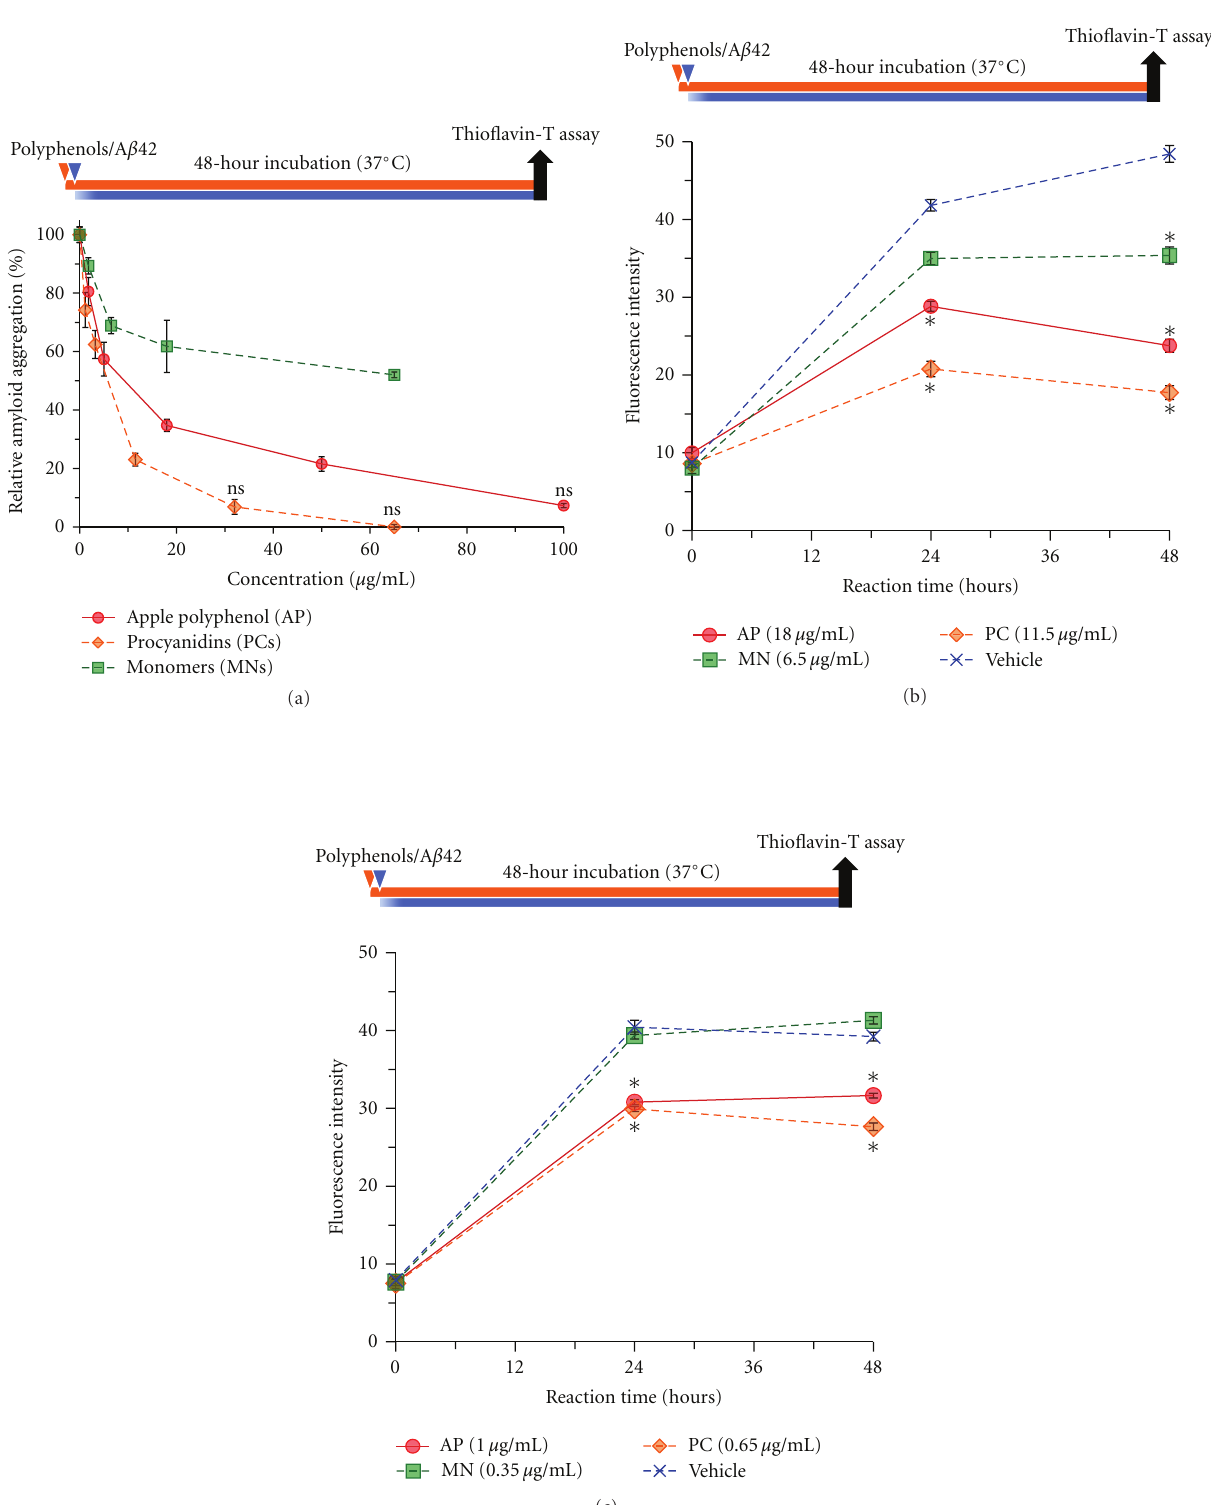
Figure 1: Procyanidins suppress A β aggregation in vitro. (a) Dose-dependent suppression of A β 42 aggregation by polyphenols as indicated by thioflavin-T (Th-T) analysis. Various concentrations of apple polyphenol (AP), procyanidins (PC), and monomers (MN) were incubated with A β 42 (final concentration 20 μ M) for 48 hours. (di ff erences from 0 hour (baseline), ns: not significant ( P < 0.01)). (b, c) Time- dependent A β 42 aggregation in the presence of polyphenols as indicated by the Th-T assay. (b) A β 42 (20 μ M) was incubated with AP (18.0 μ g/mL), PC (11.5 μ g/mL), and MN (6.5 μ g/mL). (c) A β 42 (20 μ M) was incubated with AP (1.0 μ g/mL), PC (0.65 μ g/mL), and MN (0.35 μ g/mL). (Di ff erences compared to vehicle groups, ∗ P < 0 . 001 (Dunnett’s test)). Values are the means ± s.e.m., n =